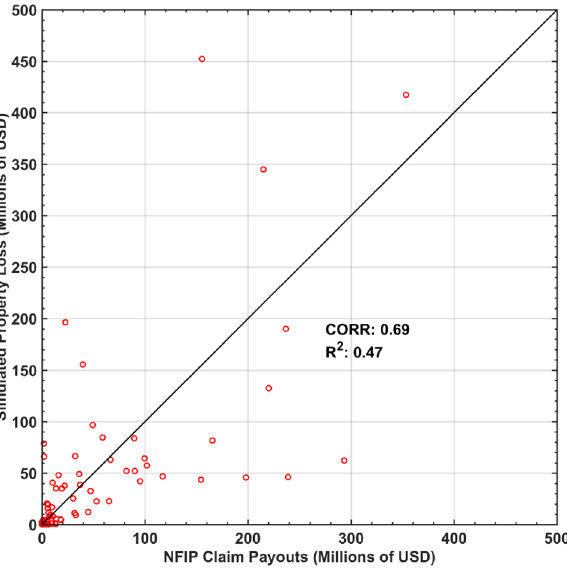
Figure 2. Economic model validation at zip-code resolution. Simulated losses during Sandy in NJ using the USACE damage functions versus FEMA NFIP payouts. Results were aggregated by zip-code and the corresponding correlation coefficient is 0.69 (R 2 = 0.47). Validation use transformed structure loss ( PL T ) instead of the structure loss ( PL ). The figure is produced using MATLAB R2020 (https ://www.mathw